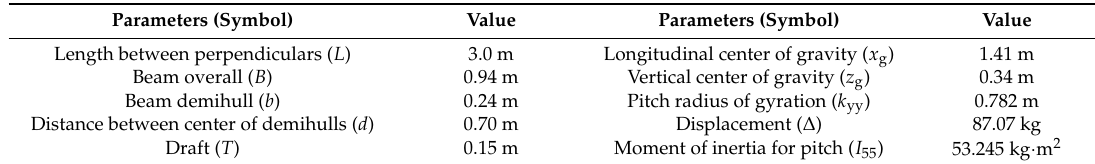
Table 1. Main characteristics of the Delft 372 catamaran